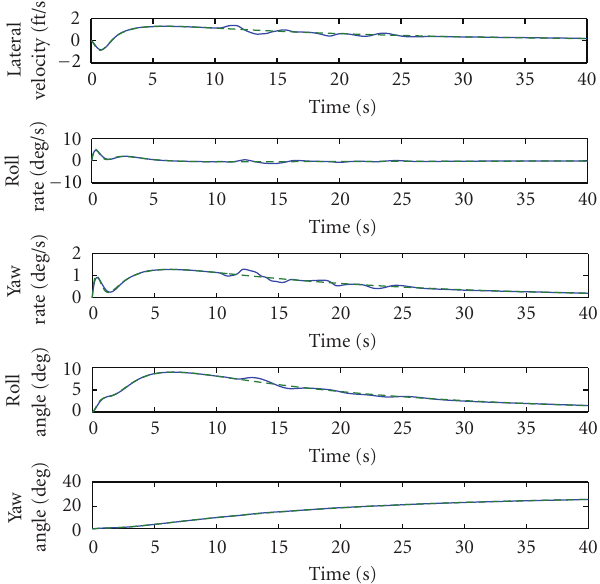
Figure 2: Time history of plant state (solid) and reference model state (dashed) (Case 1).